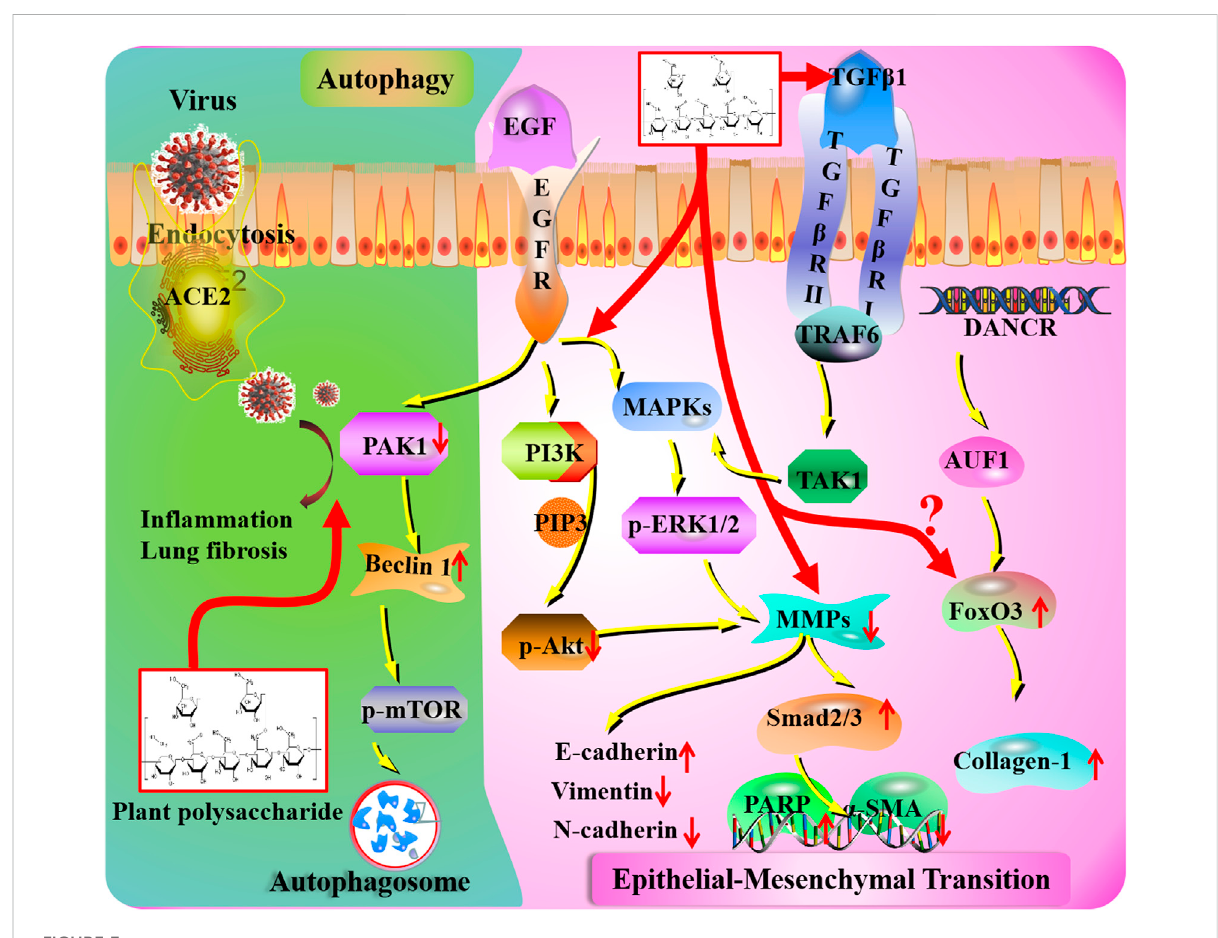
FIGURE 3 Autophagy and epithelial – mesenchymal transition mechanisms of plant polysaccharides against lung injury. COVID-19 induces lung in fl ammation and fi brosis via ACE2 (angiotensin-converting enzyme II) receptor-mediated endocytosis into the airway epithelium. The ACE2- mediated PAK1 (p21-activated kinase) signaling pathway is a potential therapeutic target of plant polysaccharides. Plant polysaccharides affect MMP (metalloproteinase) levels in COVID-19 patients. Plant polysaccharides could act on MAPKs (mitogen-activated protein kinases), PI3K (phosphatidylinositide 3-kinase), and TGF- β 1 (transforming growth factor beta) to stimulate fi broblast proliferation. Unknown links exist between COVID-19 and FoxO (forkhead box) transcription